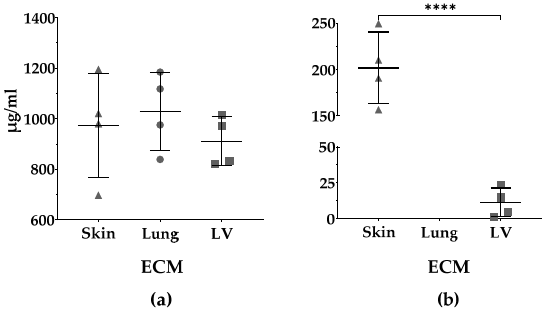
Figure 5. Quantification of protein and sulfated GAGs (sGAGs) of organ-derived ECM. ( a ) Protein content (µg/mL) of skin-ECM, lung-ECM and LV-ECM according to Lowry assay; ( b ) sGAGs content (µg/mL) skin-ECM and LV-ECM and according to DMMB assay. No sGAGs were detected in lung-ECM. All data derived from four independent experiments performed in triplicates. Data are presented as mean with SD. Mean values per experiment (n = 4) are also shown. Lowry data analyzed with one-way ANOVA ( p = ns). DMMB data analyzed with Student’s t -test **** p < 0.0001.